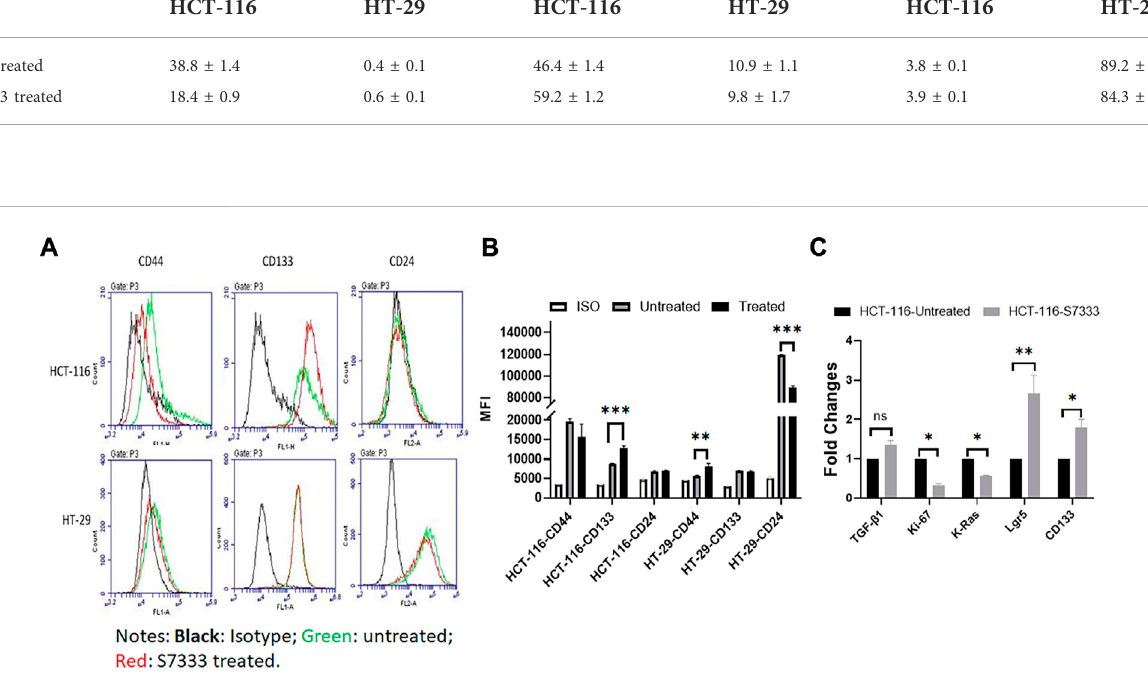
Expressions of stemness markers in HCT-116 and HT-29 after S7333 treatment. The results of fl ow cytometry analysis show the stemness surface markers CD133, CD44, and CD24 in HCT-116 and HT-29 cells after S7333 treatment (A) . For HCT-116 cells, CD133 expression increased while CD44 expression decreased and CD24 remained almost the same. For HT-29 cells, CD44 increased while CD24 decreased and CD133 remained thesame (A) . (B) shows thesummaryof the fl owcytometry results with 3repeatedexperiments. (C) , Real-time q-PCR results, show that the stem genes CD133 and Lgr5 signi fi cantly increase while the self-renewal gene TGF- β 1 slightly increases after S7333 treatment. The ability of cell proliferation decreases as indicated by low Ki67 gene expression and K-Ras gene has been suppressed by S7333 treatment. *: p < 0.05; **: p < 0.01; ***: p <